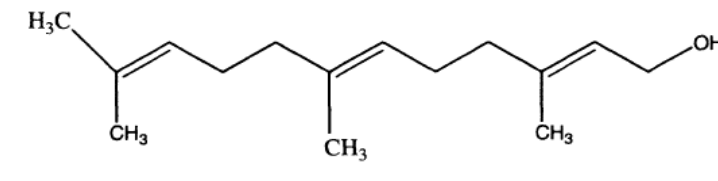
Figure 1. Chemical structure of